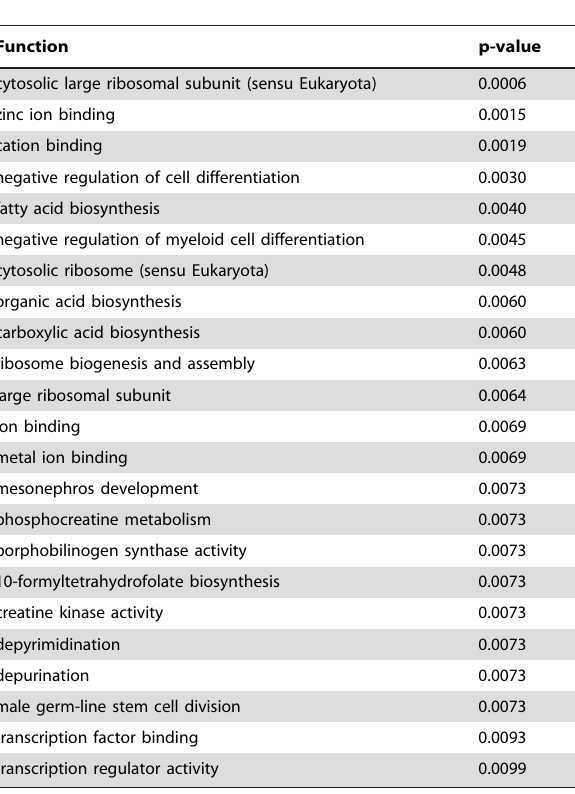
Table 5. Upregulated functions in CC B + compared to CC B-